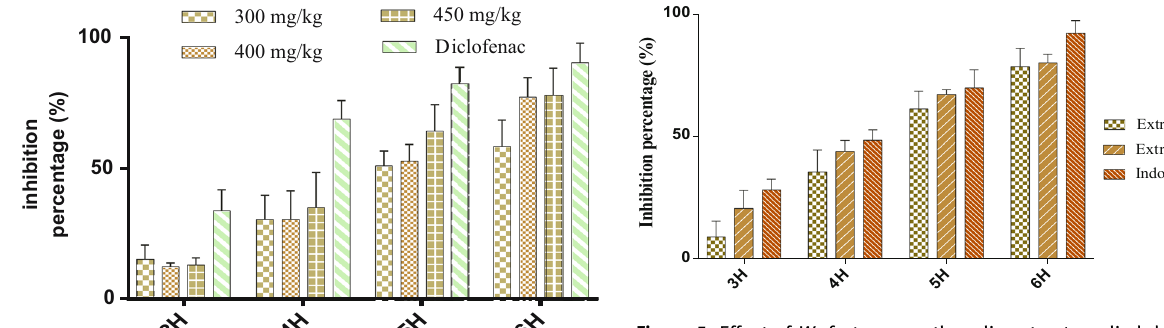
Figure 5: E ff ect of W. frutescens ethanolic extract applied dermally to 5% and 10% creams and Indomethacin on carrageenan - induced edema in rats. Values are expressed as average ± SEM.